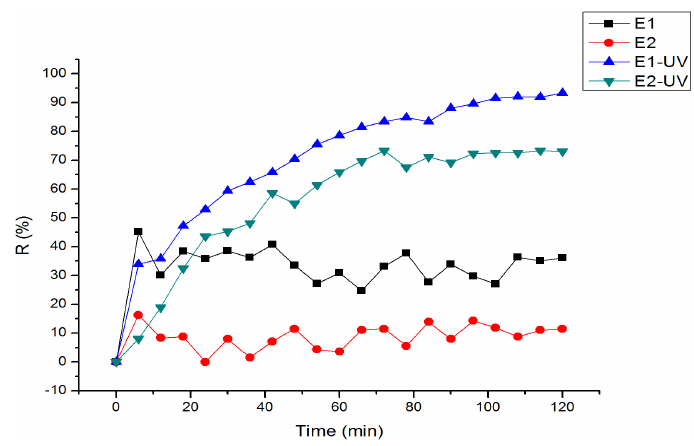
Figure 6. Removal efficiencies of E1 and E2 using the PVDF-PVP-TiO 2 ultrafiltration membrane.